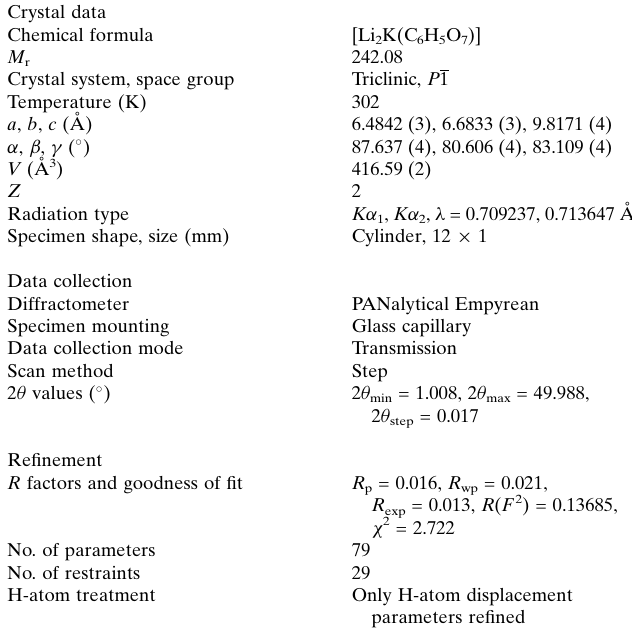
Table 2 Experimental